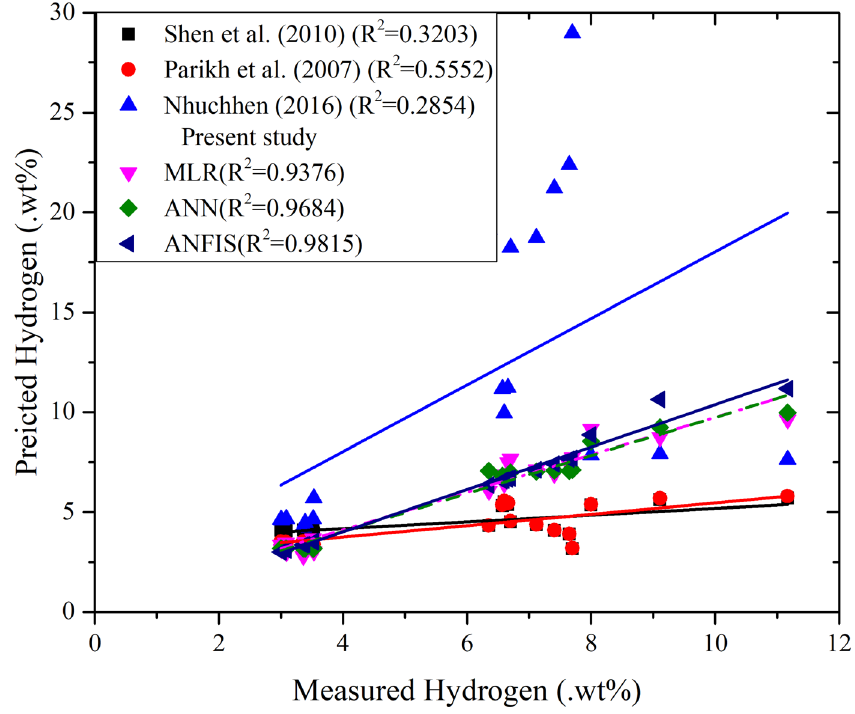
Fig. 9 Comparison of the predicted H with the measured